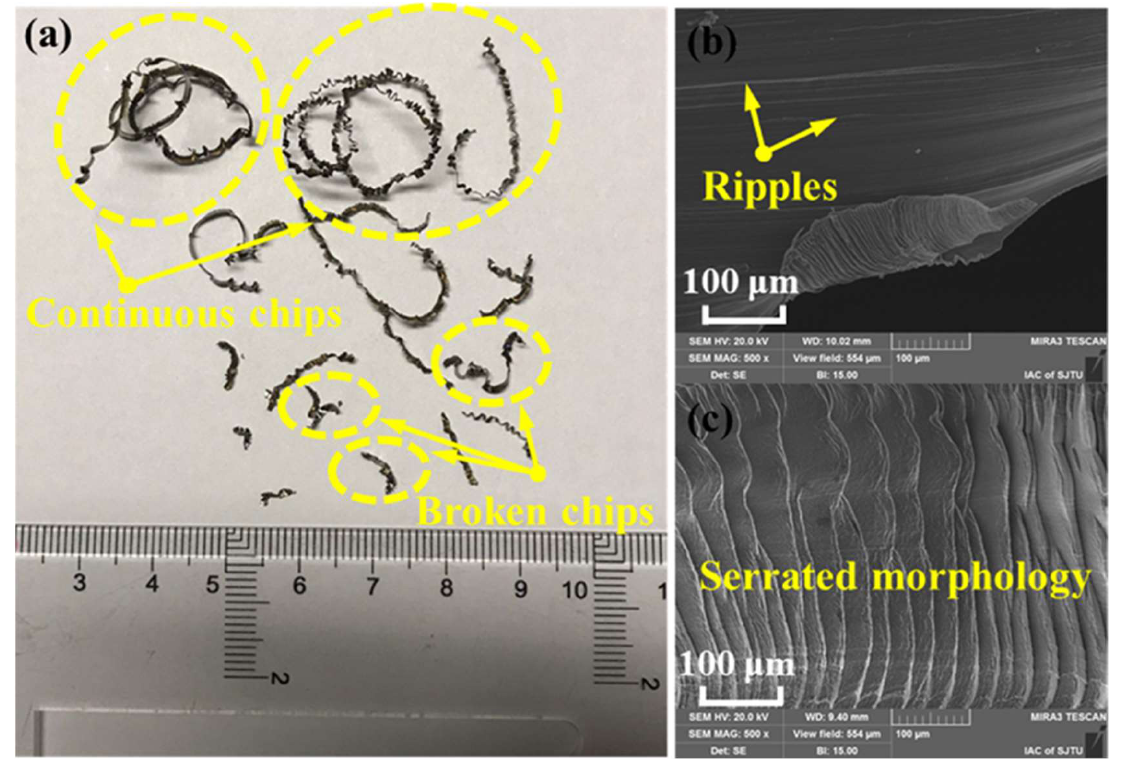
Figure 18. Chip morphologies of DMLS-fabricated Ti-6Al-4V obtained after high-speed milling: ( a ) chip present continuous ribbons and broken pieces, and chip color changes to deep purple in some positions; ( b , c ) ripples on the back surface and typically serrated morphology on the free surface of chips [125] (Reprinted with permission from [125]. Copyright 2020, Elsevier).